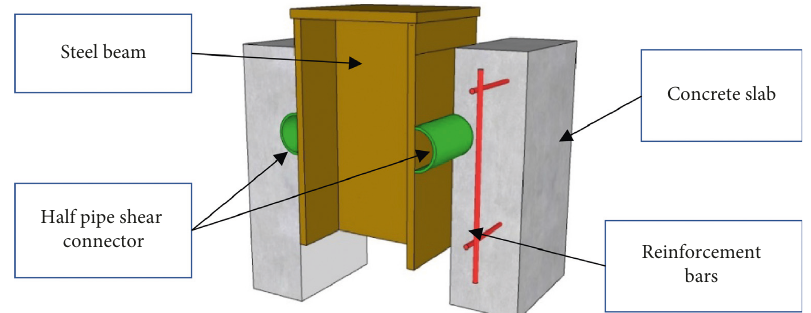
Figure 21: Steel-concrete composite deck with